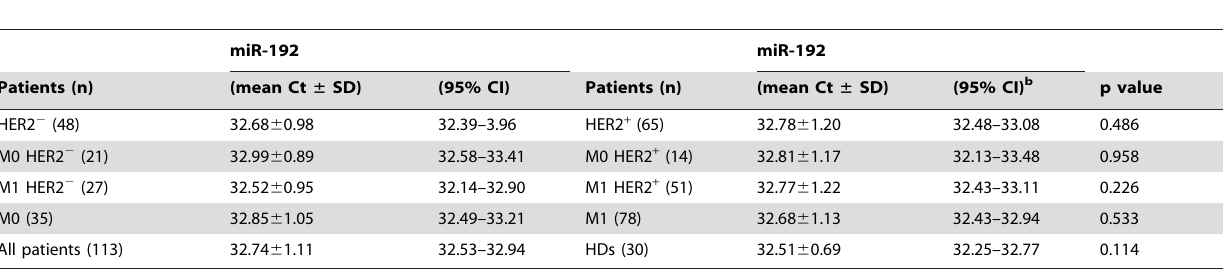
Table 2. Mean threshold cycle values of miR-192 6 standard deviation and 95% confidence interval in the serum of breast cancer patients and healthy donors.